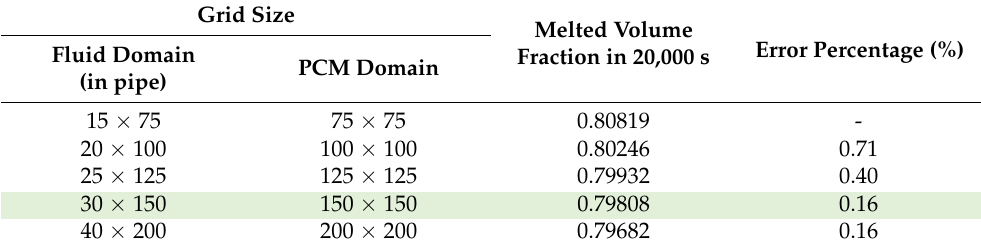
Table 2. Grid independency assessment in dimensional time of 20,000